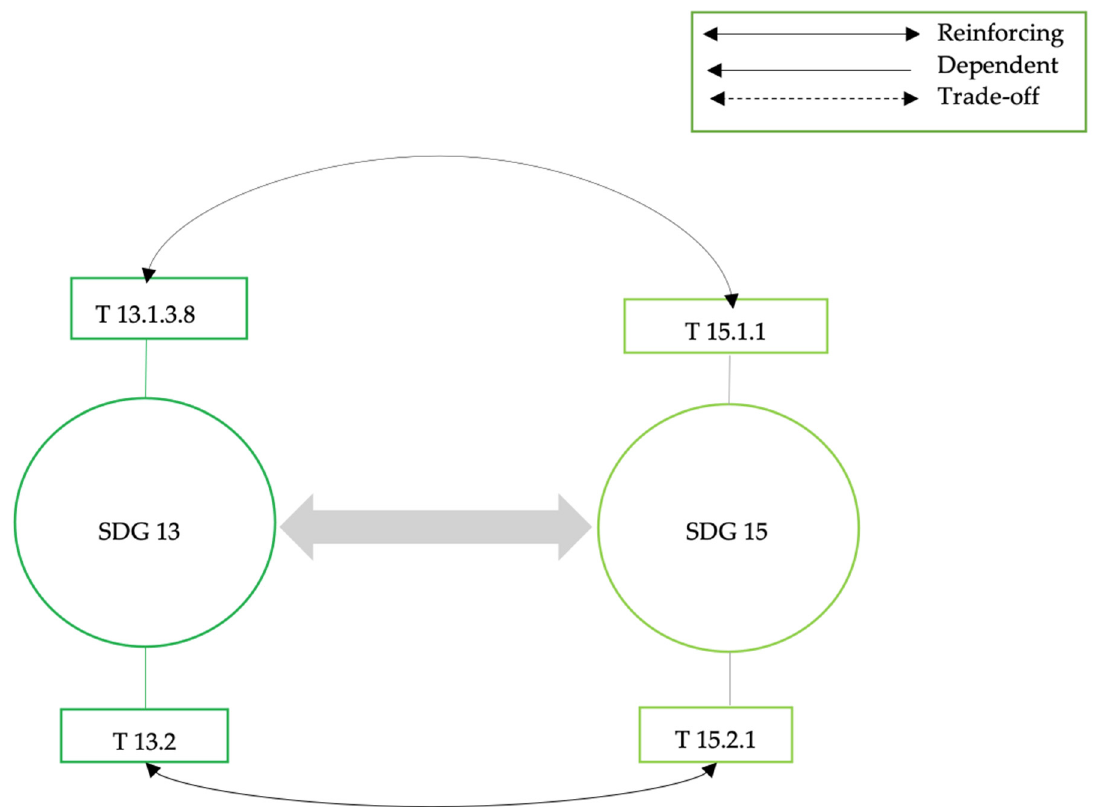
Figure 7. A conceptual linkage between SDG 13 and SDG 15.